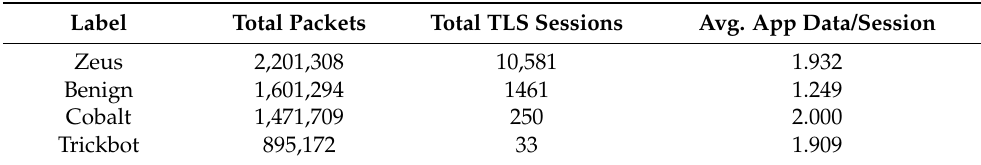
Table 1. Basic information of the